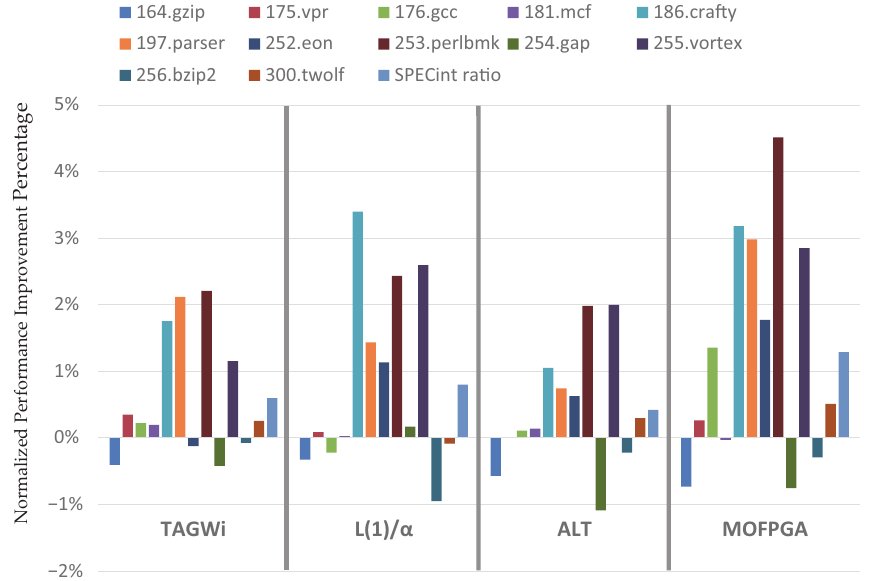
Figure 10. Performance comparison for SPEC CINT2000 at late-stage optimization in Table